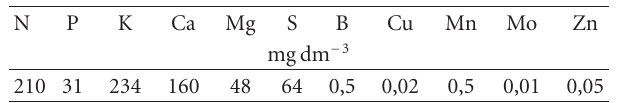
Table 1: Nutrients concentration (mgdm − 3 ) in growing solution according to Hoagland and Arnon